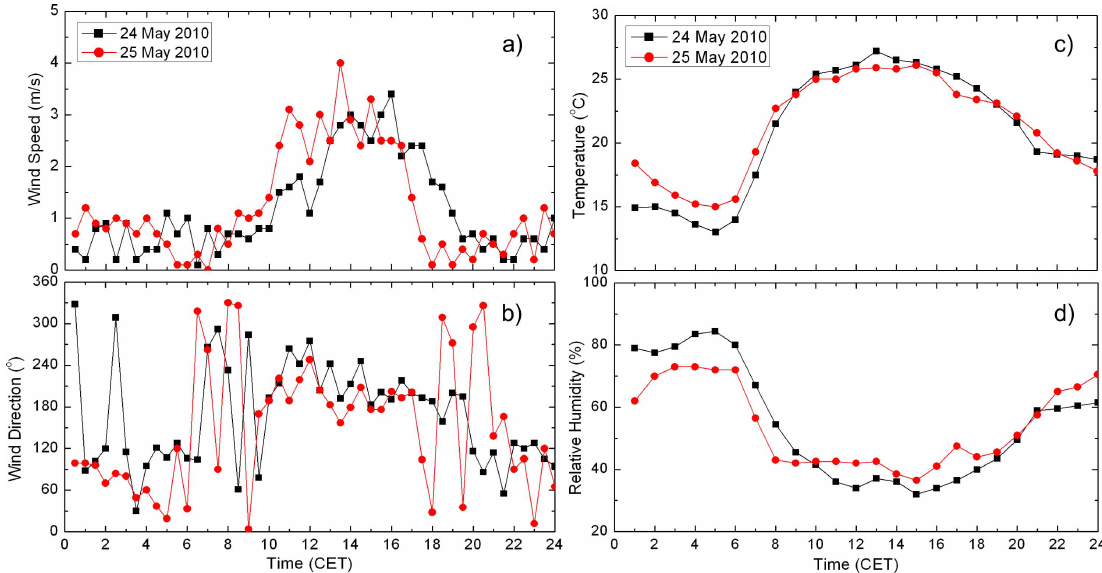
Fig. 4. Meteorological data for Nova Gorica from 24–25 May 2010. Wind information was obtained 10m above the ground and the temperature and relative humidity 2m above the